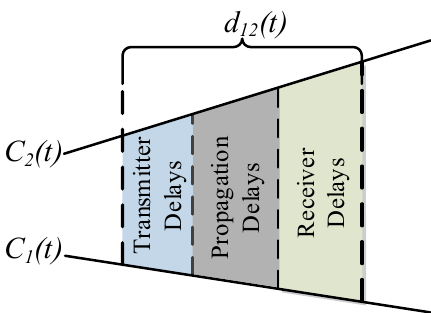
Figure 12. Three groups of messaging time error sources: transmitter side delays, propagation delays, and receiver side delays.